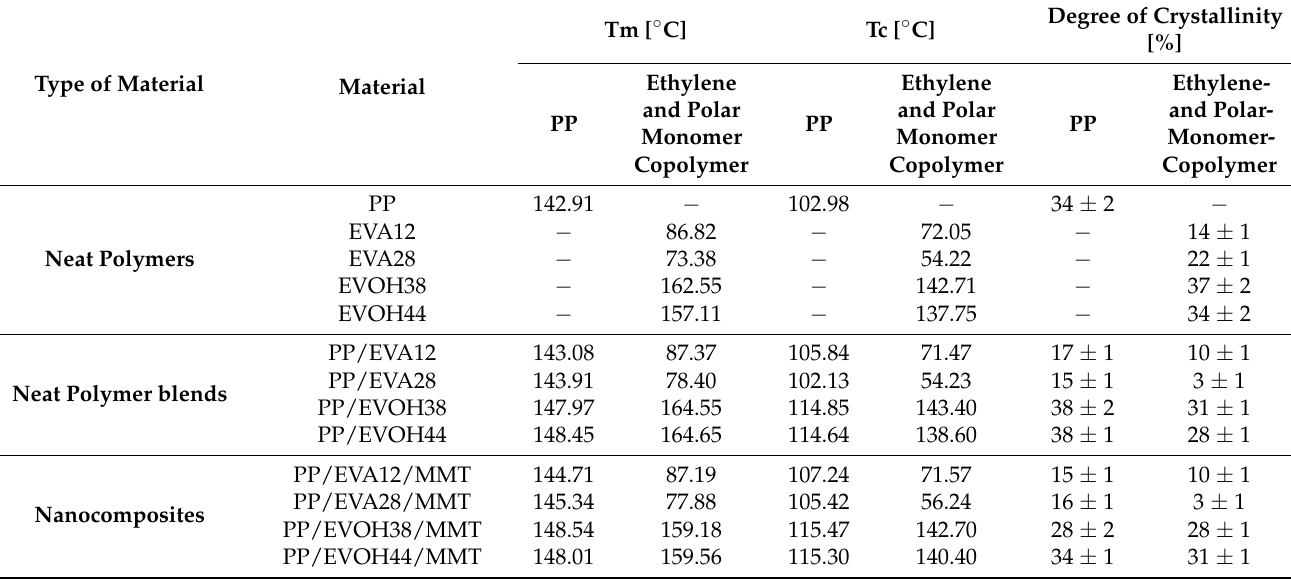
Table 2. Thermal transitions and degree of crystallinity for the neat polymers, polymeric materials into the blends and nanocomposites. Determined by DSC